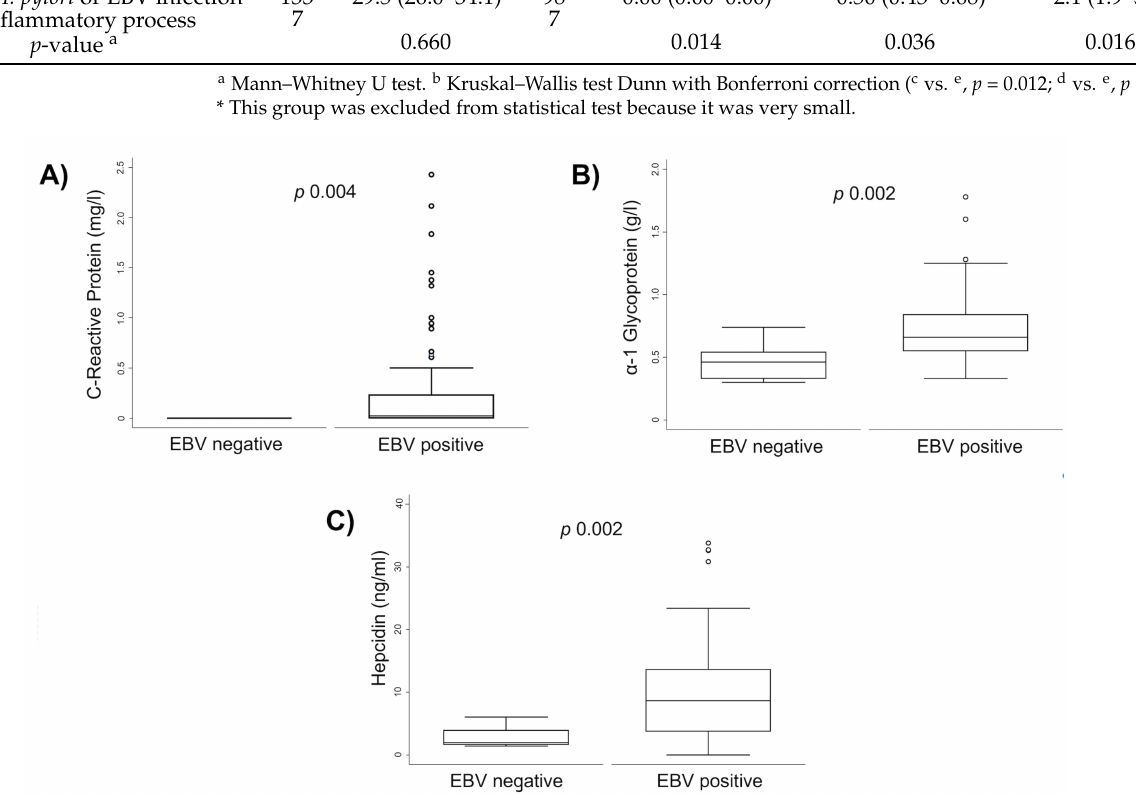
Figure 1. EBV infection is associated with enhanced levels of hepcidin and acute-phase protein in schoolchildren. Concentration of ( A ) C-Reactive protein, ( B ) α -1 Glycoprotein, and ( C ) hepcidin were measured in children and compared according to their EBV infection status using the Mann– Whitney’s